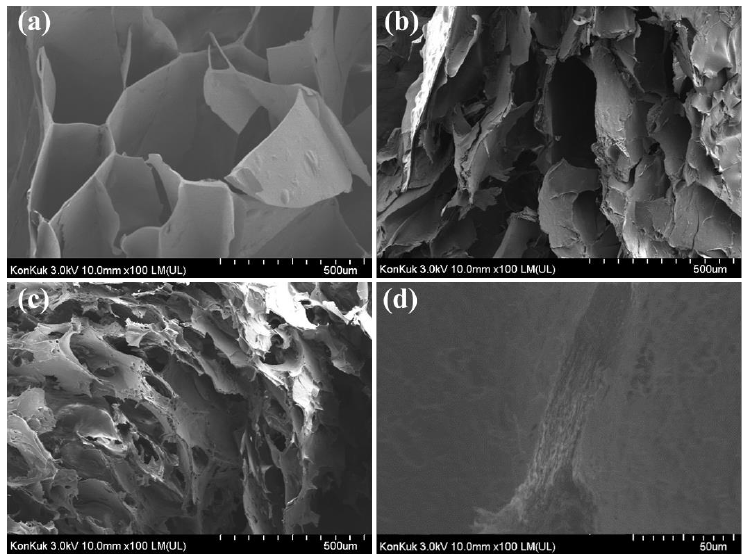
Figure 7. FE-SEM images illustrating the microstructures of cross-sectioned hydrogels: ( a ) SG gel; ( b ) S1C1 gel (Low magnification); ( c ) CMC gel; ( d ) S1C1 gel (High magnification).